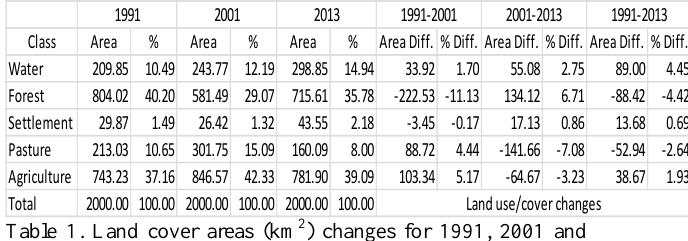
Table 1. Land cover areas (km 2 ) changes for 1991, 2001 and 2013.